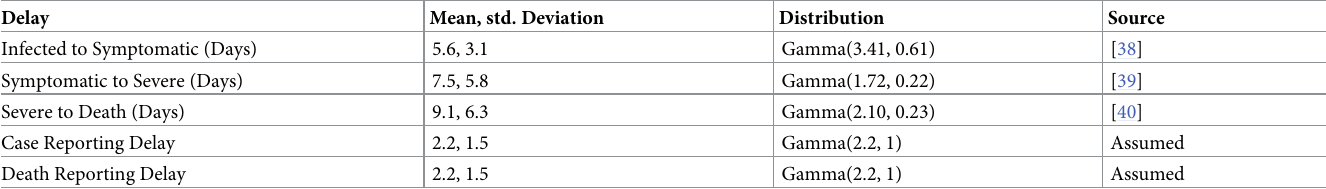
Table 2. Delay Distributions.